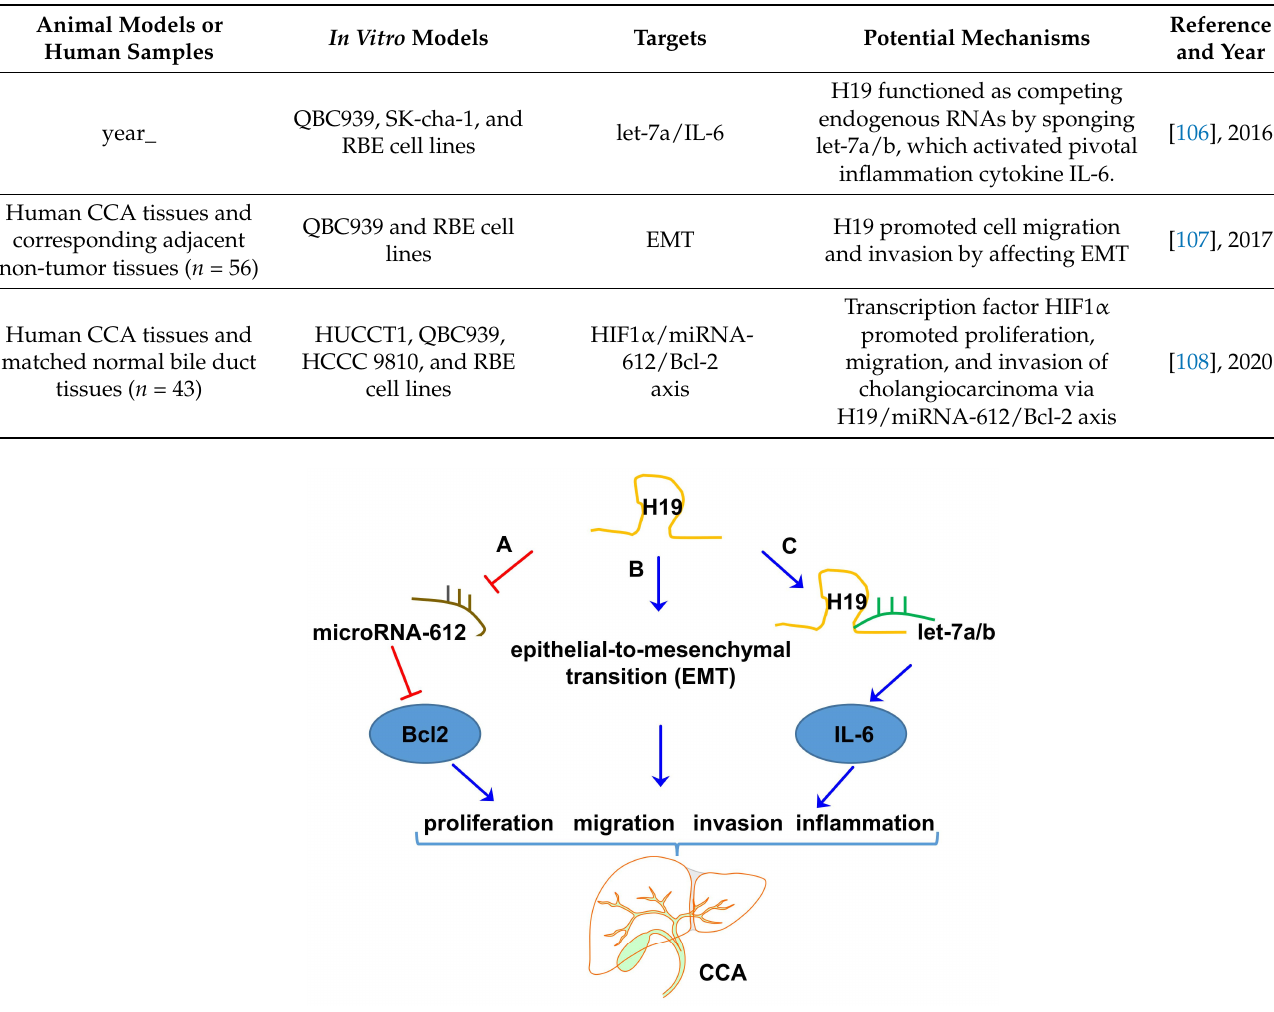
Figure 4. Potential mechanisms of LncRNA H19 in CCA. ( A ) LncRNA H19 promoted the